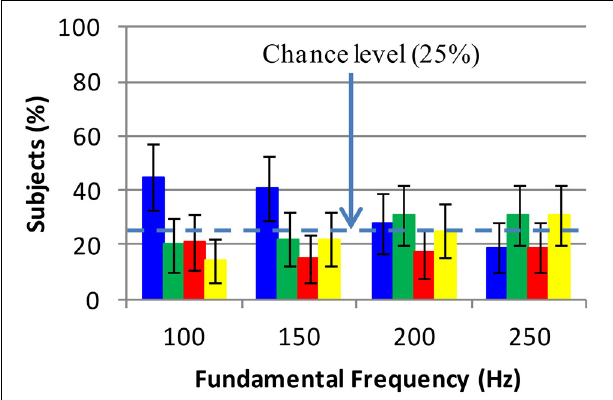
FIGURE 5 | Color selections for fundamental frequency: each colored bar shows the selection rate of the same color. The error bars show the 99.17% confidence intervals for the selection rates. Blue has been associated with fundamental frequency 100Hz. No colors have been associated with 150, 200, and 250Hz because all selection rates for them are approximately at chance level. Thus the associations between color and fundamental frequency are only strong at 100Hz.